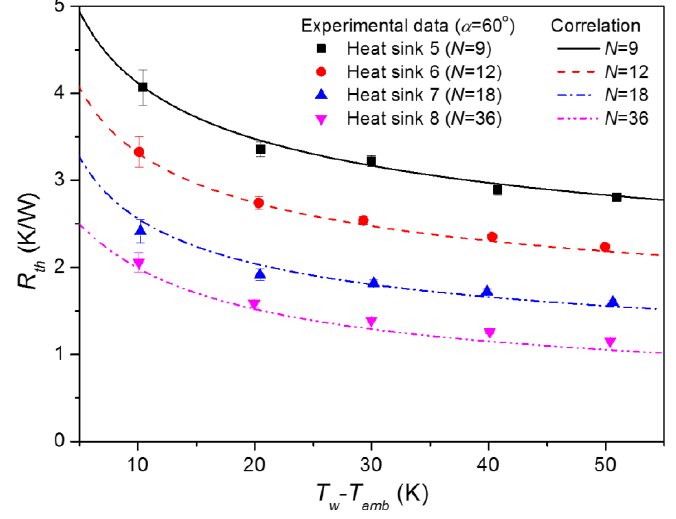
Figure 7. Thermal resistances for various fin numbers.